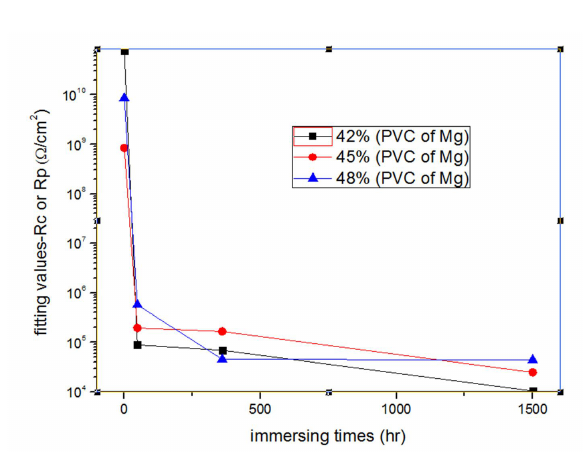
Figure 5: Change rule of EIS date of different